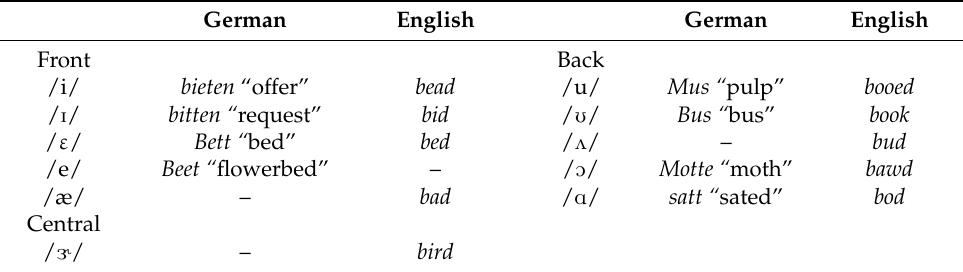
Table 1. German and English vowels included in Study